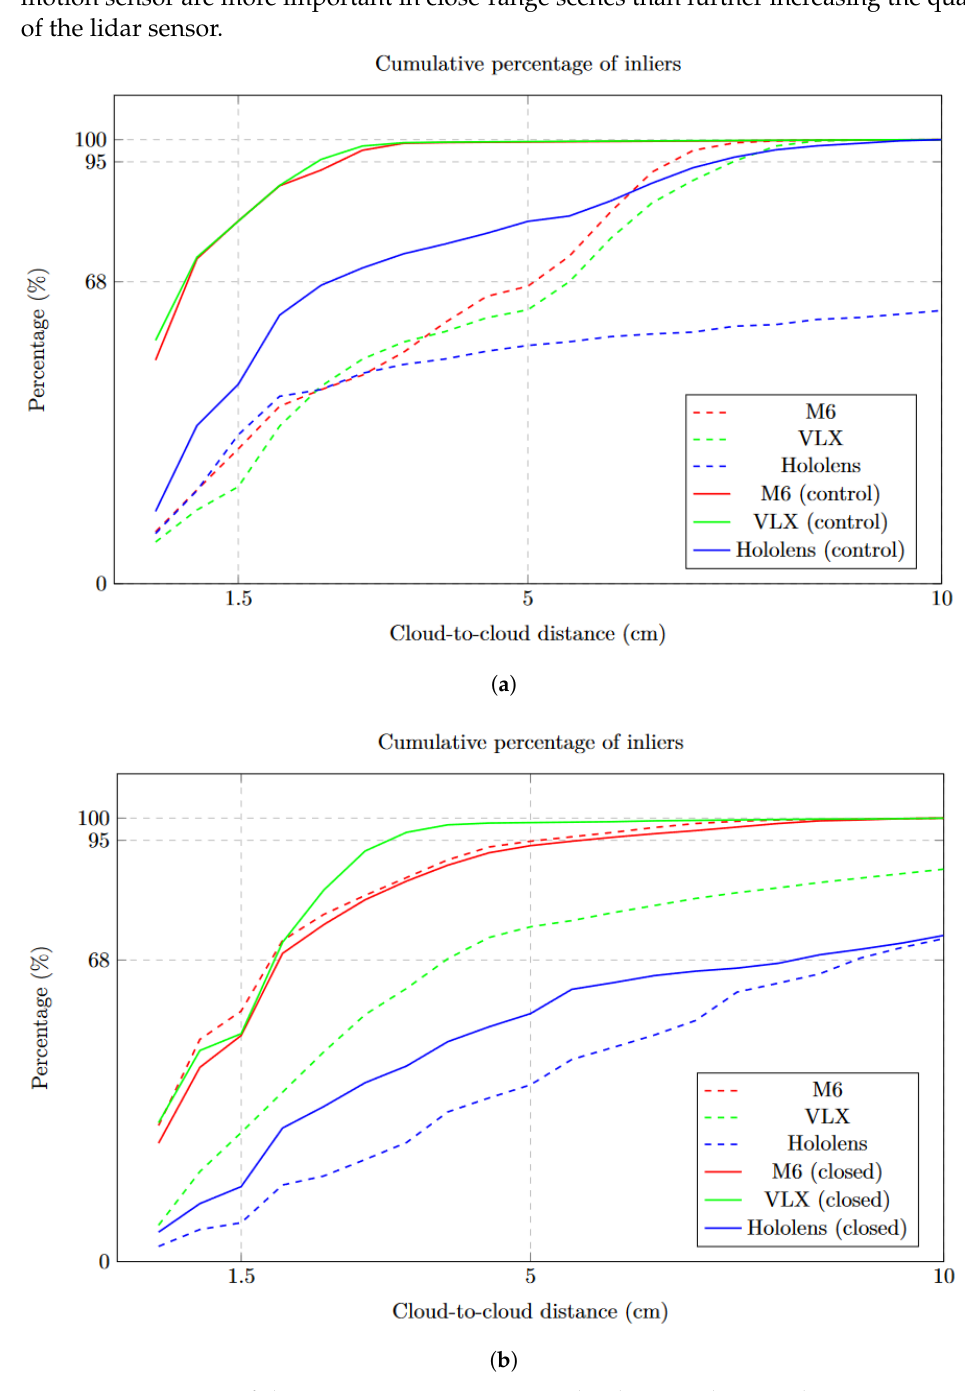
Figure 6. Overview of the Sensor capacity test: Graphs showing the cumulative percentage of c2c-distances between the target and reference point clouds for ( a ) D-hall: The impact of a control network and ( b ) E-hall: The impact of